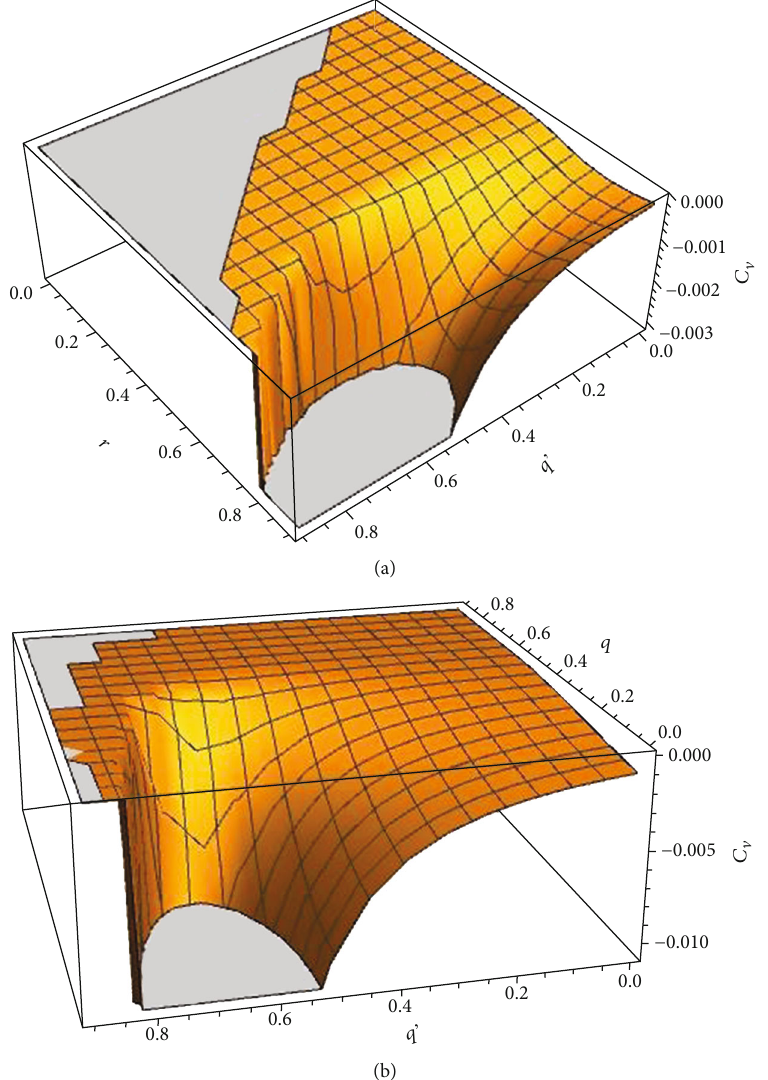
when q , q ′ vary and V